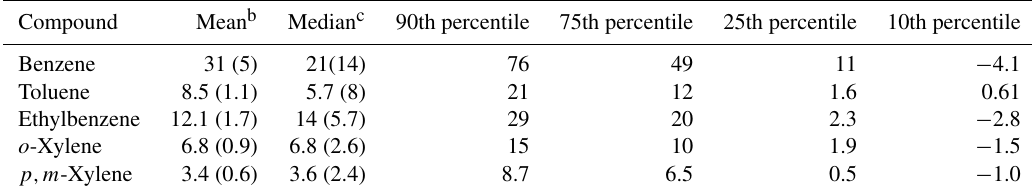
Table 13. Overview of R [OH]d t a of light aromatic VOC calculated from their stable carbon isotope ratios.